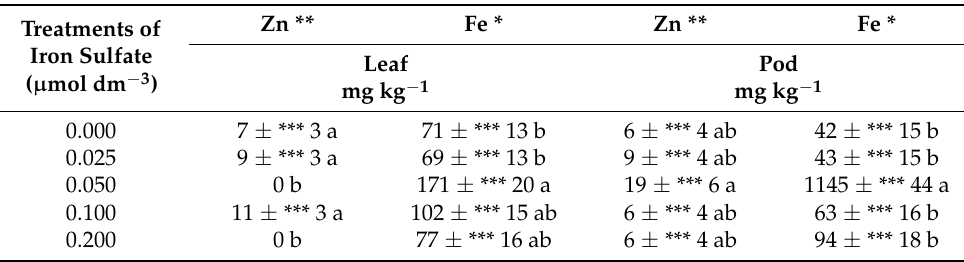
Table 1. Average micronutrient content of Zn and Fe in foliar tissue and bean pod, due to iron application in different concentrations.